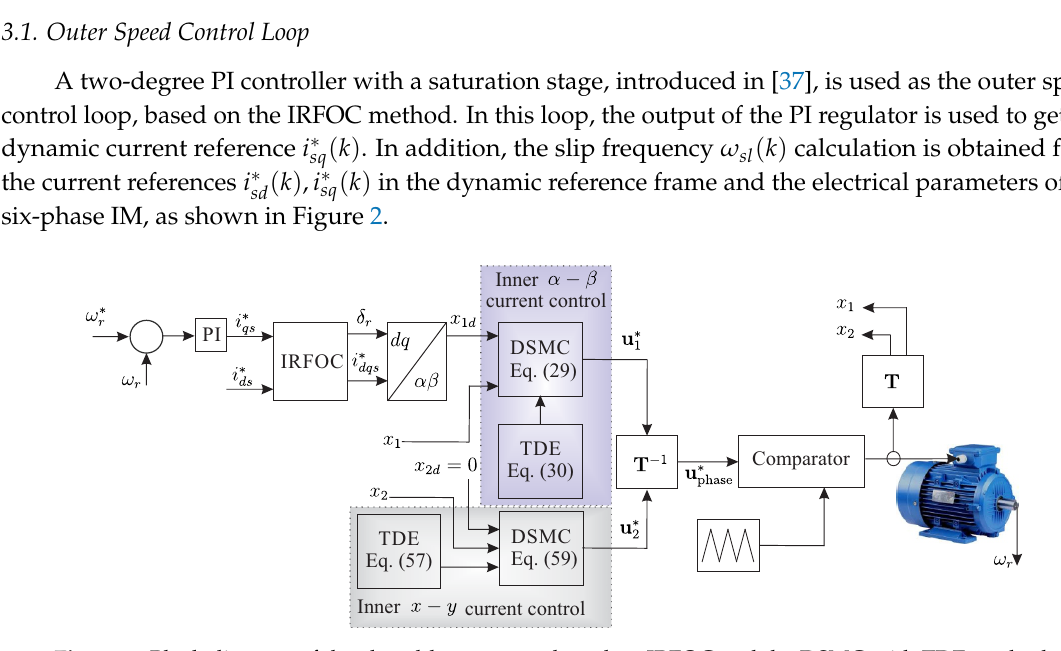
Figure 2. Block diagram of the closed-loop system based on IRFOC and the DSMC with TDE